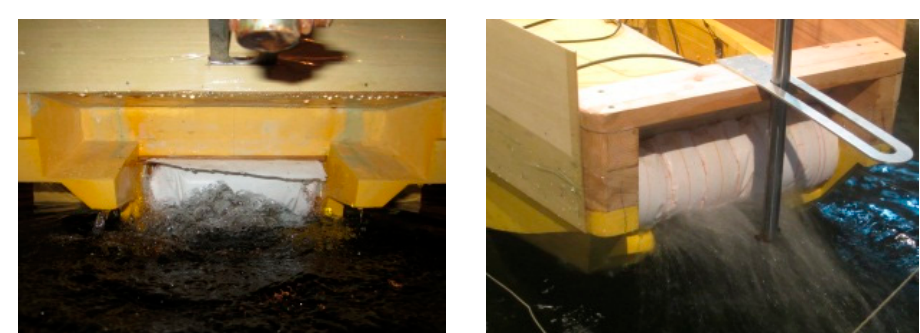
Figure 6. Air cushion system.